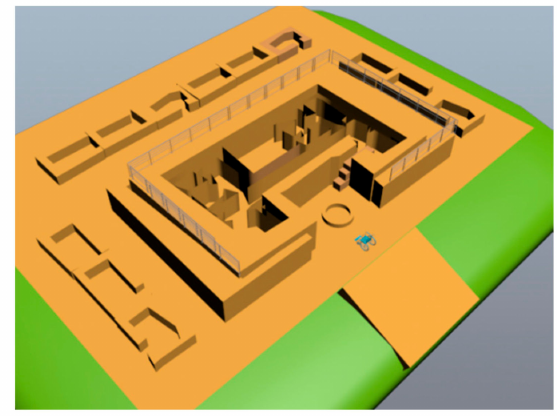
Figure 8. Synthetic model designed for the initial phase of the VR application